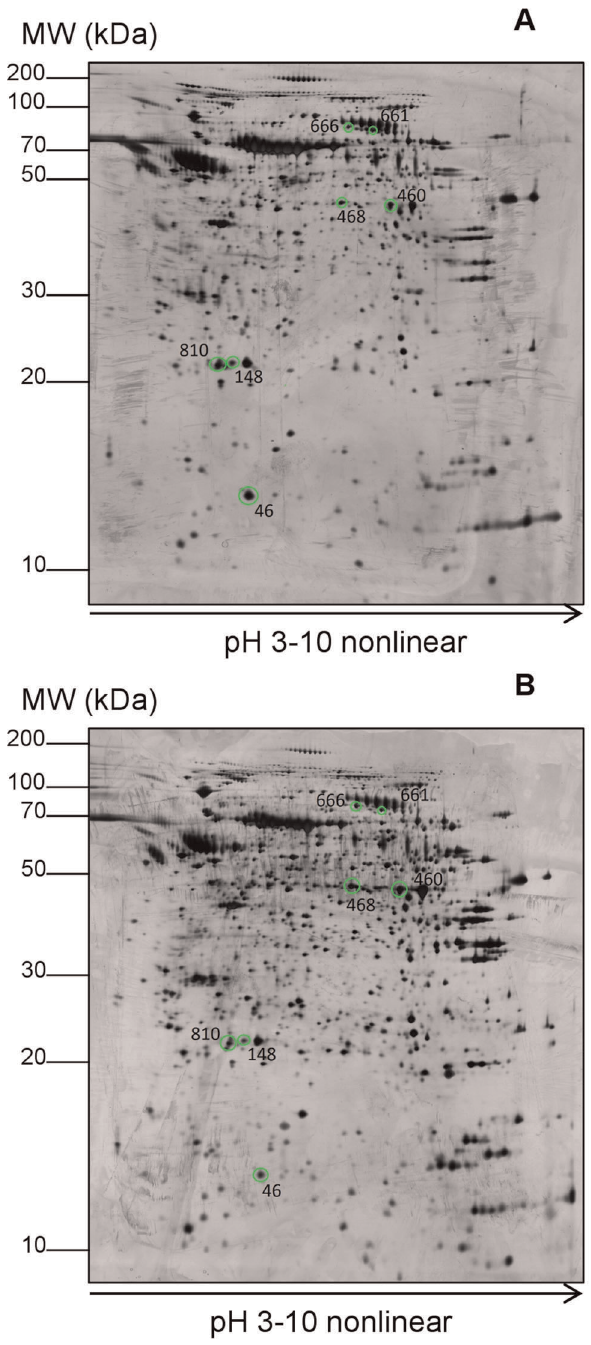
Figure 2. Analysis of proteins released from HepG2 cells. Two- dimensional gel electrophoresis (2D-GE) analysis of proteins released from HepG2 cells in control (A) and treatment with 60 m g/ml methanol extract of the T. indica fruit pulp (B). Analysis was performed on four independent biological replicates for proteins released from the control as well as treated cells. Approximately 1500 spots per gel within the pH 3–10 range were detected. Seven spots (circled and labeled) were differentially expressed ( p , 0.05) in which four were significantly up- regulated and three were significantly down-regulated.